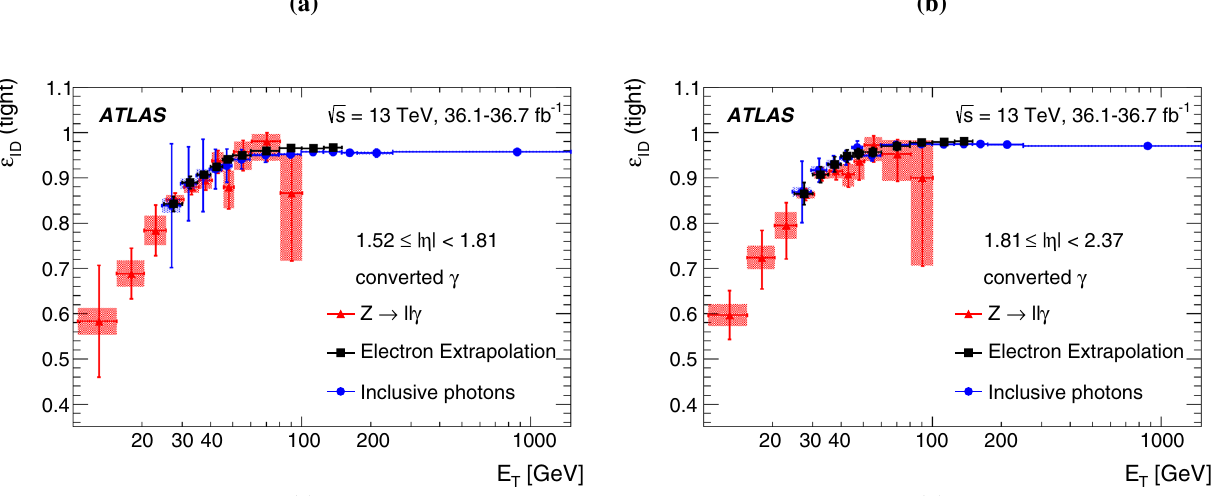
the sum in quadrature of the statistical and systematic uncertainties esti- mated in each method. The shaded areas correspond to the statistical uncertainties. The last bin extends to 1.5